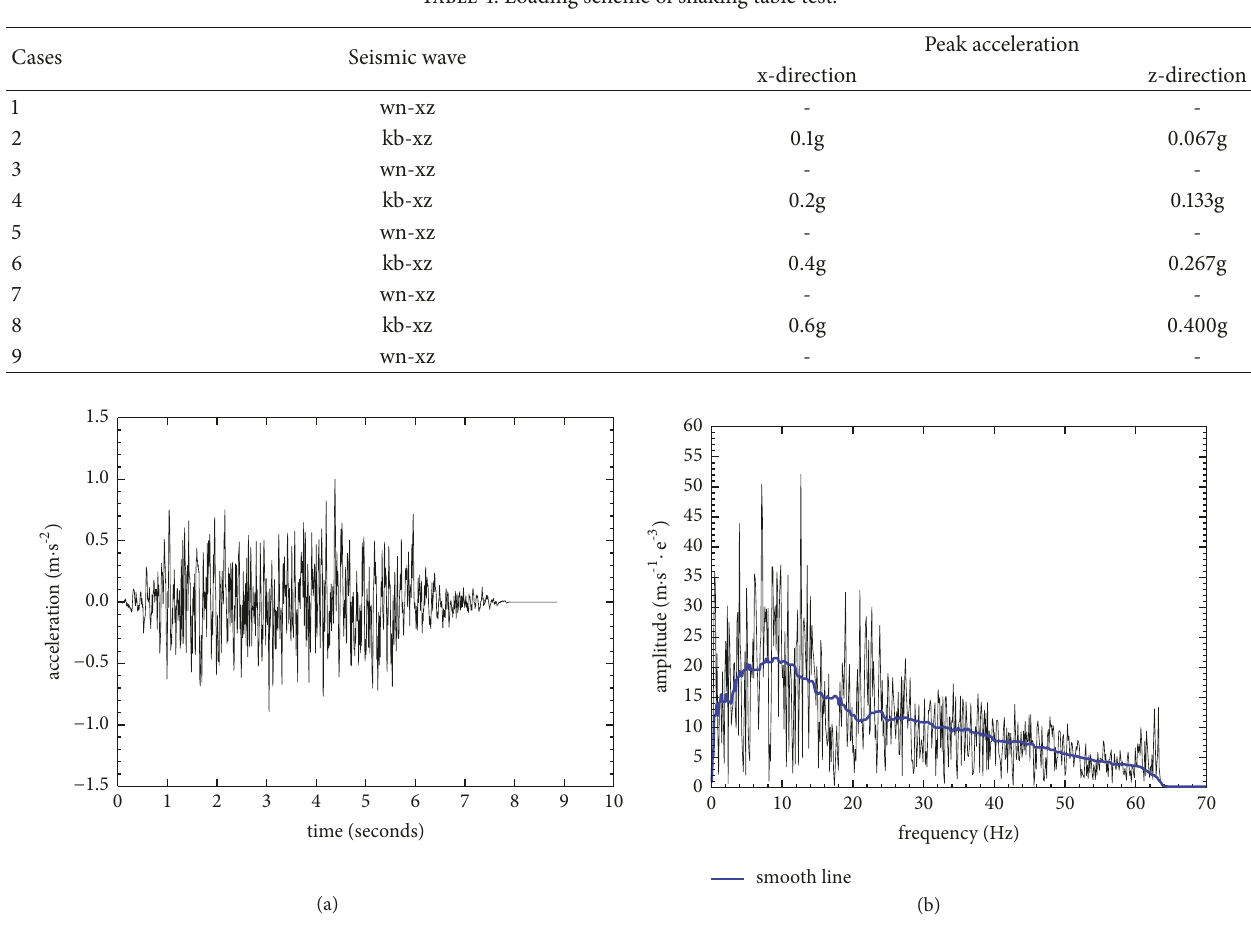
Table 4: Loading scheme of shaking table test.